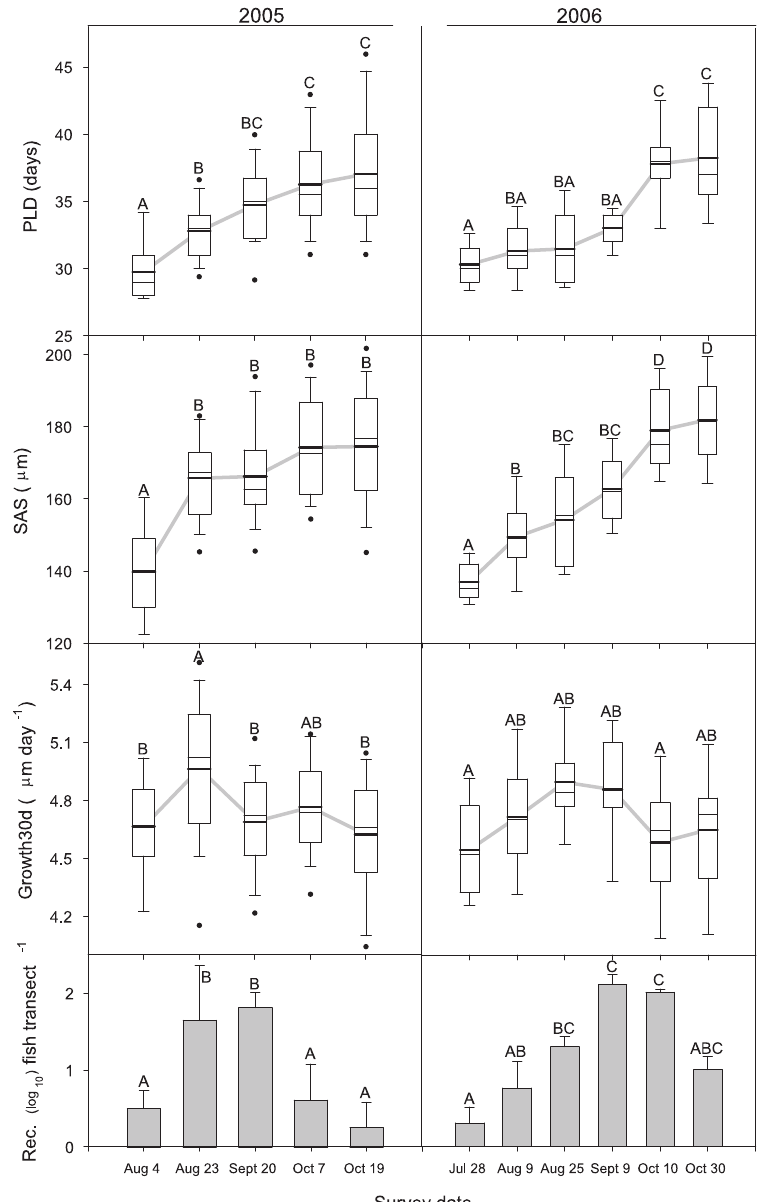
Fig. 3. –Temporal variation of Pelagic Larval Duration (PLD), Size at Settlement (SAS), average larval growth over 30 days post hatch (Growth) for Coris julis . Bars represent recruitment magnitude ± SE. Bars or boxes not sharing letters are significantly different (Tukey HSD post hoc